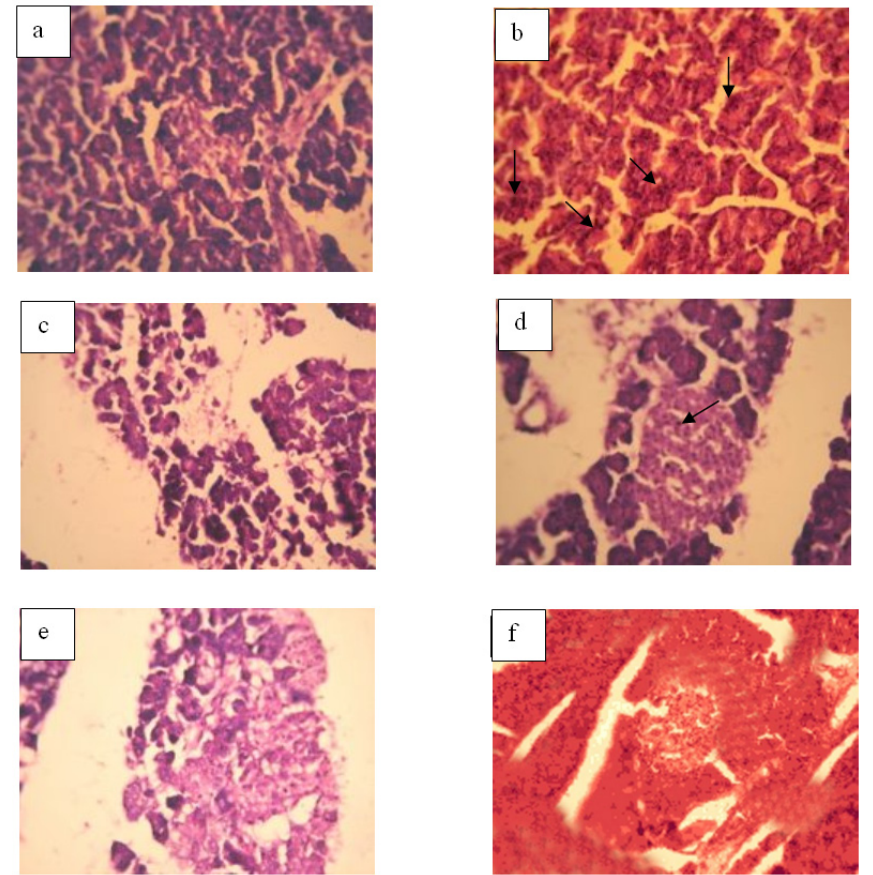
Fig. 1. Histopathological examination of Pancreatic tissues of control and experimental animals: Group I-normal islet cells (a); Group II-shrinkage of islet cells and growth of adipose tissue (b); Group III-Mild shrinkage of islet cells (c); Group IV-reduction in adipose tissue and pancreatic islets within normal limit (d); Group V-Very mild shrinkage of islet cells (e); Group VI-normal islet cells